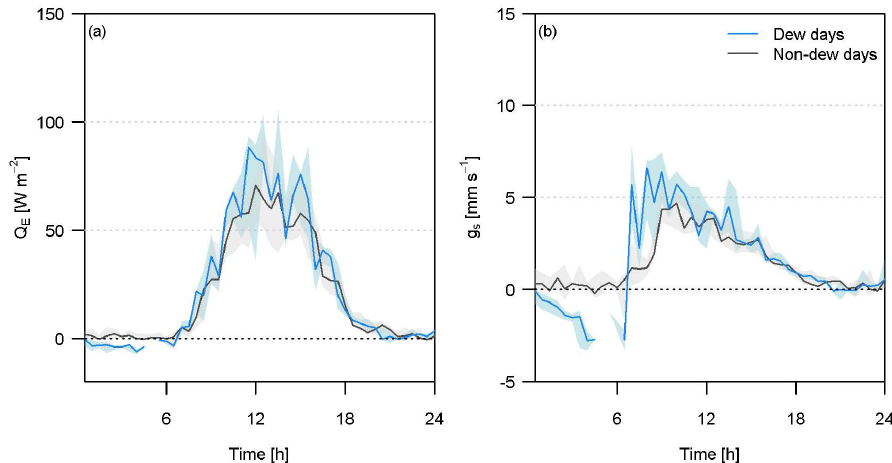
Fig. 10. Median diurnal cycles (lines) and interquartile ranges (shading) of (a) latent heat flux and (b) surface conductance for selected days with heavy dewfall (23–26, 30 March 2012) and little or no dewfall (22, 27–29, 31 March 2012, 1–2 April 2012). Values of g s > 40mms − 1 or g s < − 10mms − 1 have been